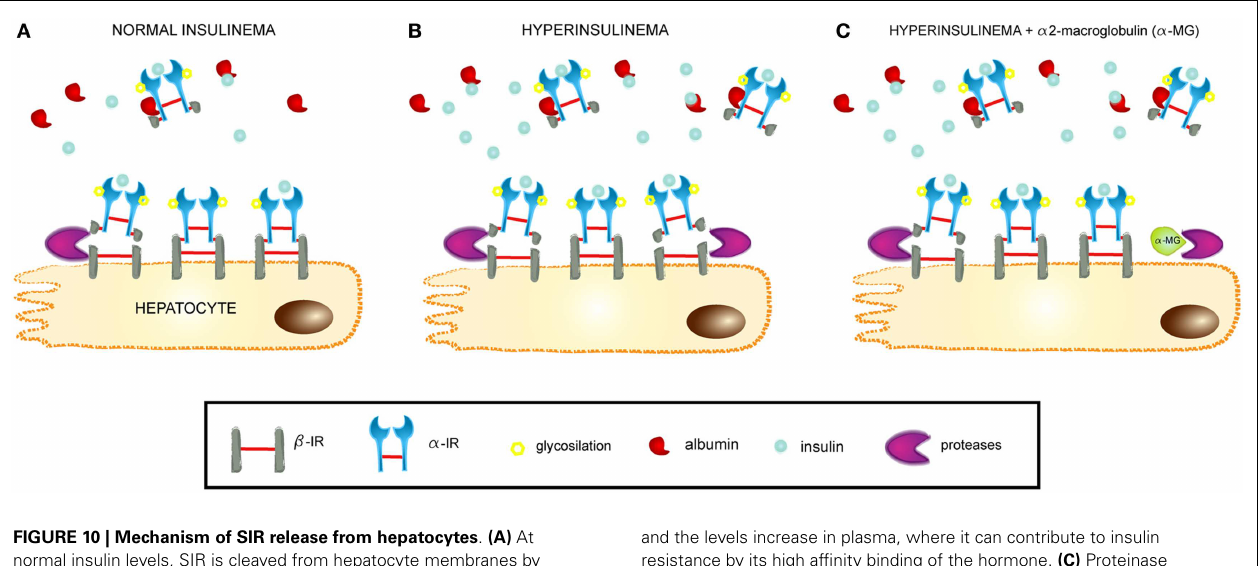
and the levels increase in plasma, where it can contribute to insulin resistance by its high affinity binding of the hormone. (C) Proteinase inhibitors, such as alpha2-macroglobulin, modulate SIR release by impeding the cleavage of the insulin receptor within a segment of the